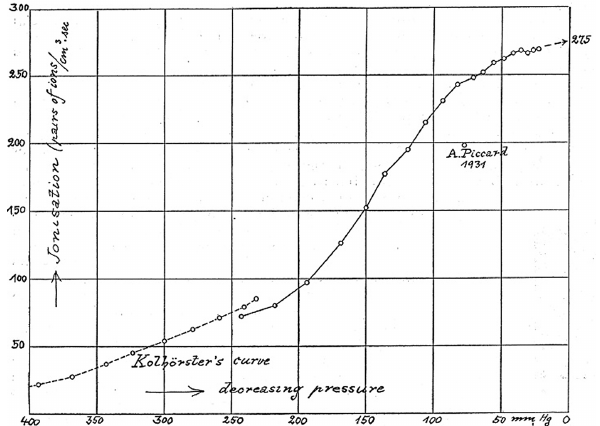
Figure 2. Ionisation data from Regener (1932) taken using an electrometer and a 2.1L ionisation chamber. The ionisation rate (ionpairscm − 3 s − 1 ) is shown as function of decreasing pressure (mmHg). Also shown are data from Kolhörster and Piccard. The extrapolated value is shown as 275ionpairscm − 3 s − 1 . As was cus- tomary at the time, no errors are shown on the data points. Using these data Regener was able to confirm the results of Kolhörster and infer that the rate of production of ionisation had reached a maximum value, which he extrapolated to 275ionpairscm − 3 s − 1 . He defined this as the “intensity of the cosmic radiation” at “its en- trance to the atmosphere”.